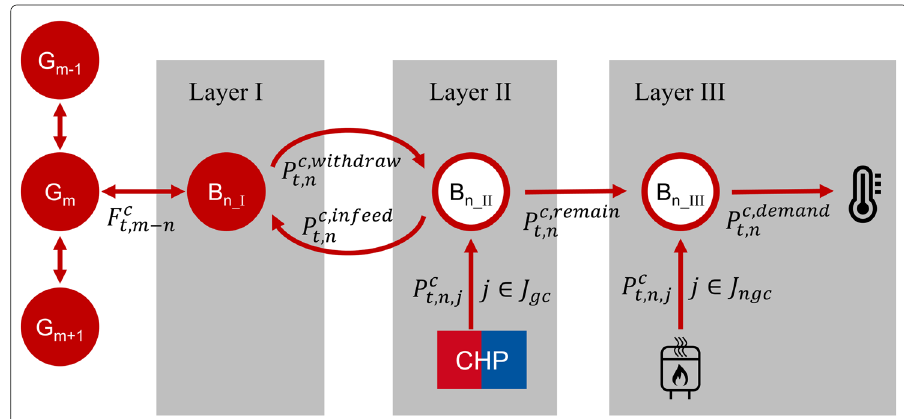
Fig. 2 Each building or central conversion node n is modeled with three layers. Layer I represents the grid connection of node n , balancing withdrawal and infeed with the edge flows. Layer II considers the output from conversion units, which can feed their output into the grid, while layer III considers the output of all remaining units, the exogeneous energy demand and the input into all technologies in node n